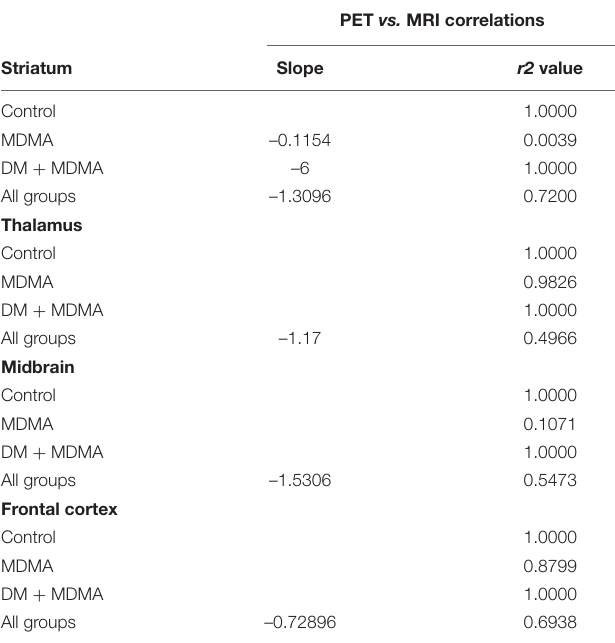
vs. MDMA; Figure 7 ). Detailed results of the MRI volumetric differences in vivo are shown in Table 3 .